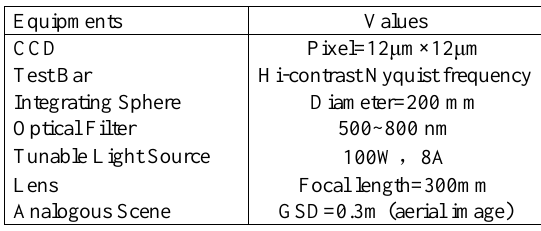
Table 1. Main experimental